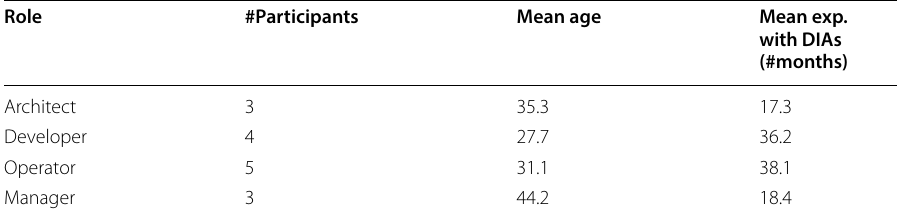
Table 1 Focus-groups population